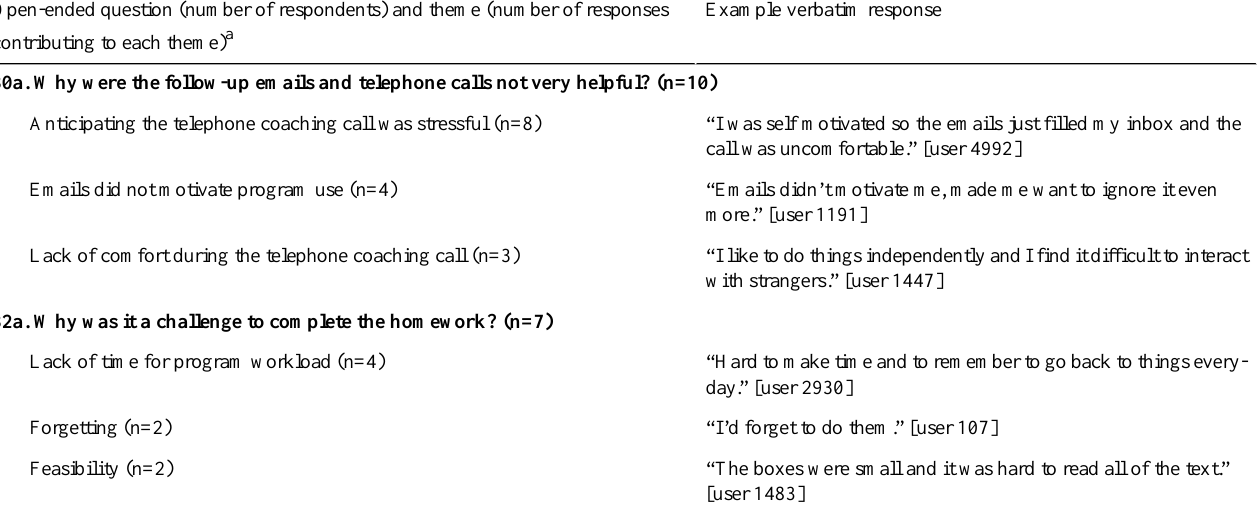
Table 10. Themes and responses from open-ended items from the User Experience Questionnaire for Internet-based